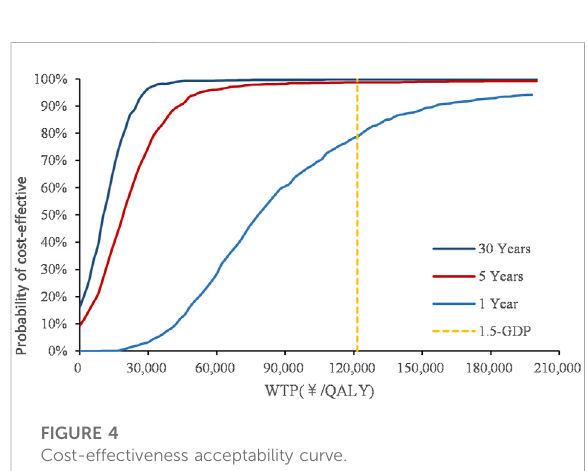
FIGURE 3 ICER scatterplot.